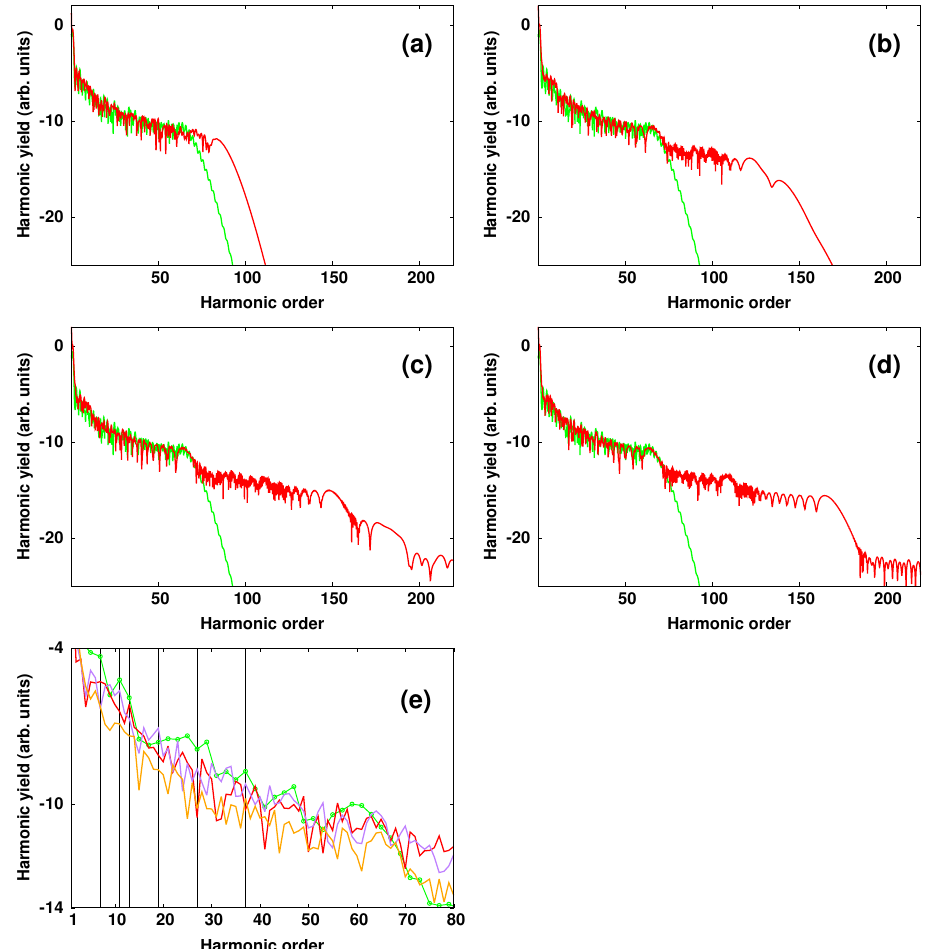
Figure 5. (Color online). 1D—calculations of the harmonic spectra obtained for a peak intensity of the IR single cycle pulse of 1 × 10 13 W/cm 2 and at different wavelengths (red curve): ( a ) λ IR = 2 λ NIR , ( b ) λ IR = 4 λ NIR , ( c ) λ IR = 6 λ NIR , and ( d ) λ IR = 8 λ NIR . For reference, the HHG spectrum obtained with the NIR pulse alone is shown with green curve in ( a – d ) and also with green empty circles in ( e ). A zoom of the spectrum in the harmonic order range [1:80] is shown in ( e ) for: λ IR = 10 λ NIR (red curve), λ IR = 6 λ NIR (purple) at 1 × 10 13 W/cm 2 . Orange curve shows the spectrum at the IR intensity of 4 × 10 13 W/cm 2 ( λ IR = 10 λ NIR ). Vertical lines indicate the suppressed odd—order harmonics. The parameters of the NIR pulse are: λ NIR = 1.27 µ m, T c = 10 cycles, δφ = 0 and I NIR = 1 × 10 14 W/cm 2